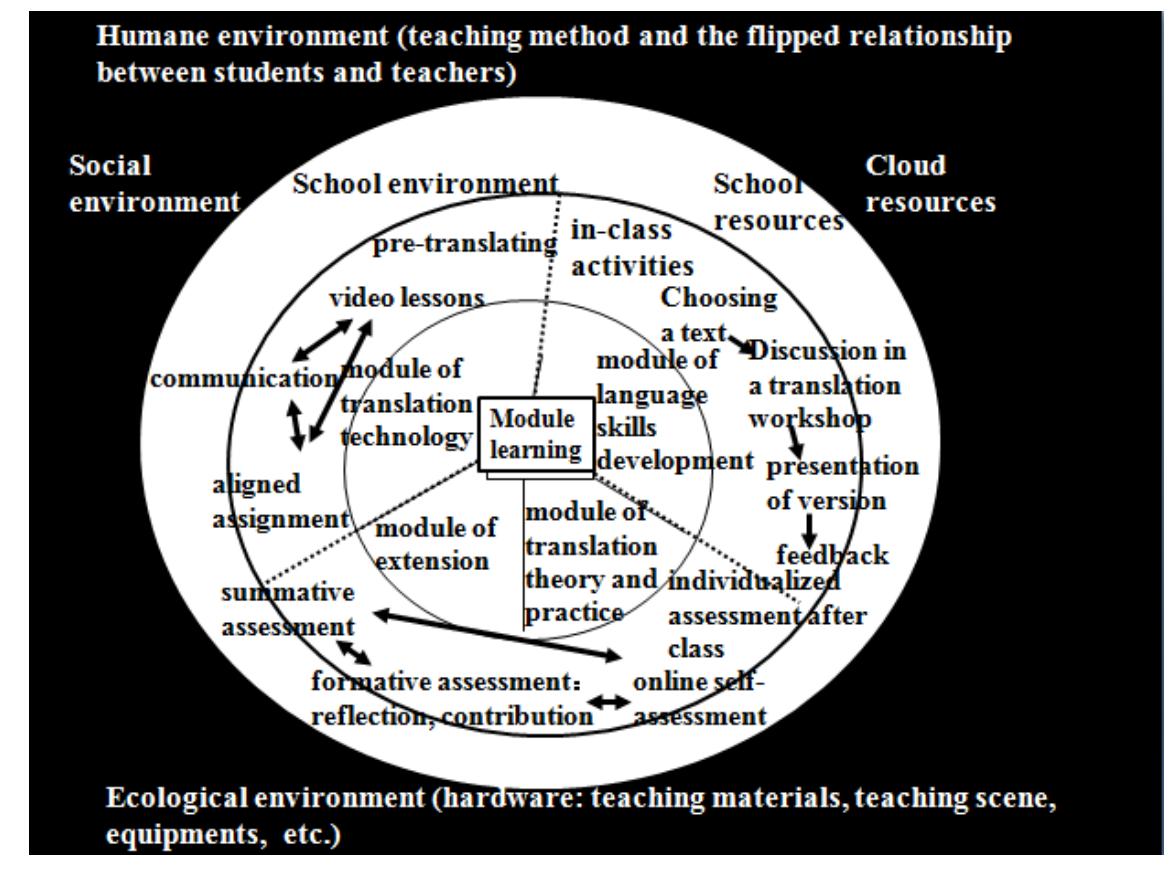
Figure 1 Ecological flipped classroom model of translation Teaching Constructing a harmonious and dynamically-balanced ecological